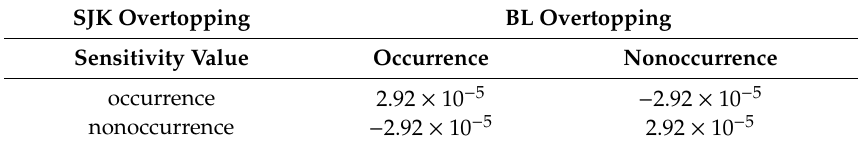
Table 7. The sensitivity analysis of SJK Overtopping, according to the BL Overtopping node.